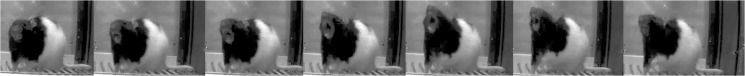
Consecutive frames (< 500 msecs) of an empathy test clip showing yawning of an Observer animal during the shock period.